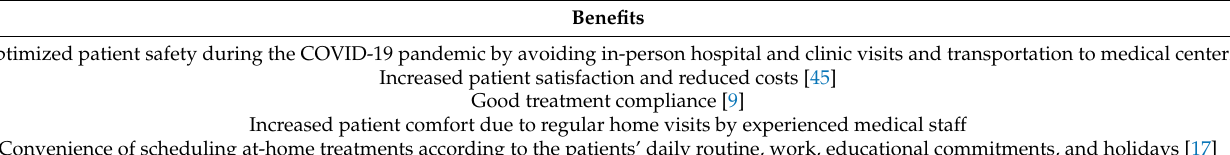
Table 3. Considerations for successful home-based enzyme replacement therapy program implementation.